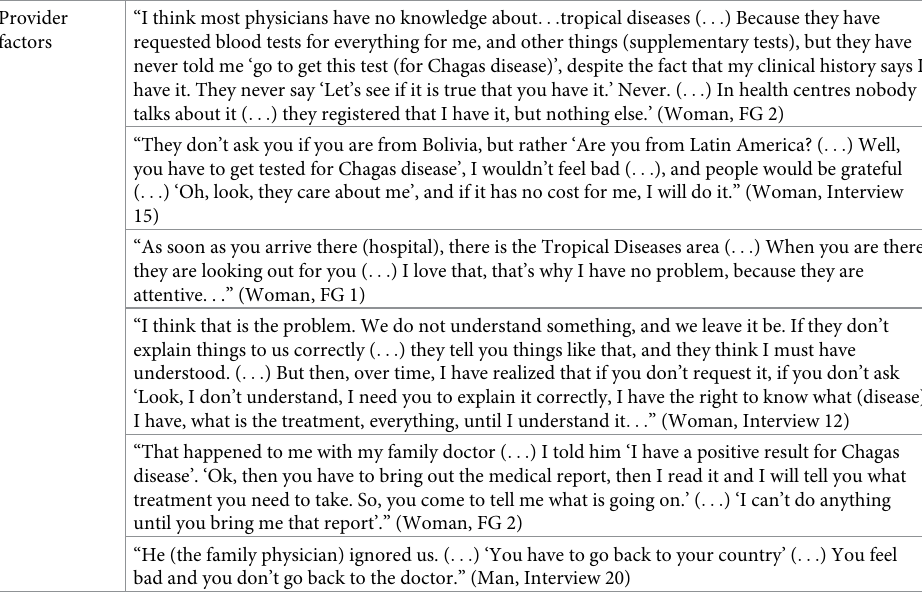
Table 9. Quotes related to provider